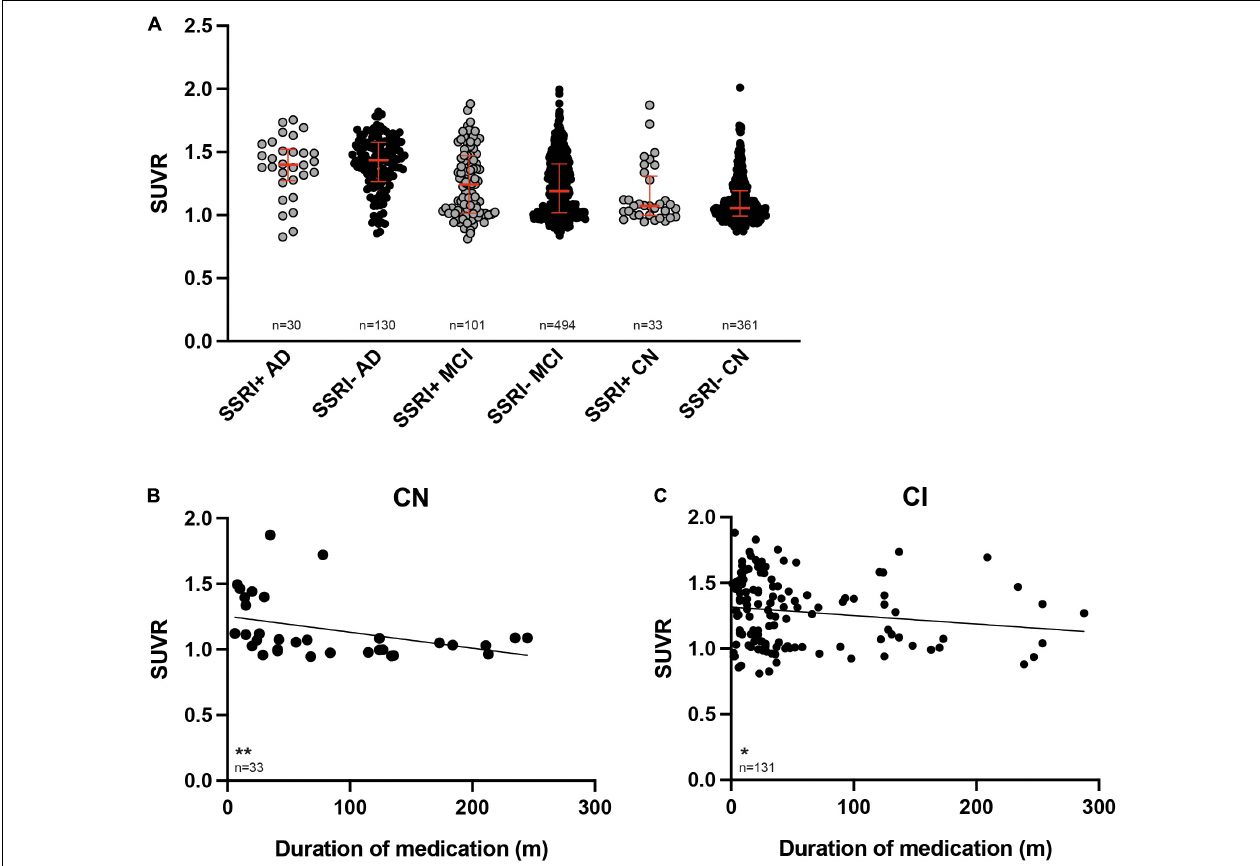
FIGURE 2 | 18 F-Florbetapir uptake in SSRI-treated and untreated subjects. (A) SUVR was significantly higher in AD-patients compared to MCI patients as well as between AD or MCI patients compared to CN (ANCOVA). SUVR did not show significant differences between SSRI-treated (SSRI + ) and untreated (SSRI − ) subjects regardless of the diagnosis (Mann–Whitney U test; red bars represent median ± interquartile range). (B) SUVR showed a time-dependent inverse correlation to the duration of medication in cognitively normal patients. (C) SUVR also showed a time-dependent negative relation to the duration of medication in cognitively impaired patients. Spearman correlation; * p < 0.05; ** p < 0.01. SUVR, standard uptake value ratio; CN, cognitively normal controls; CI, cognitively impaired patients; AD, Alzheimer’s disease; MCI, mild cognitive impairment.